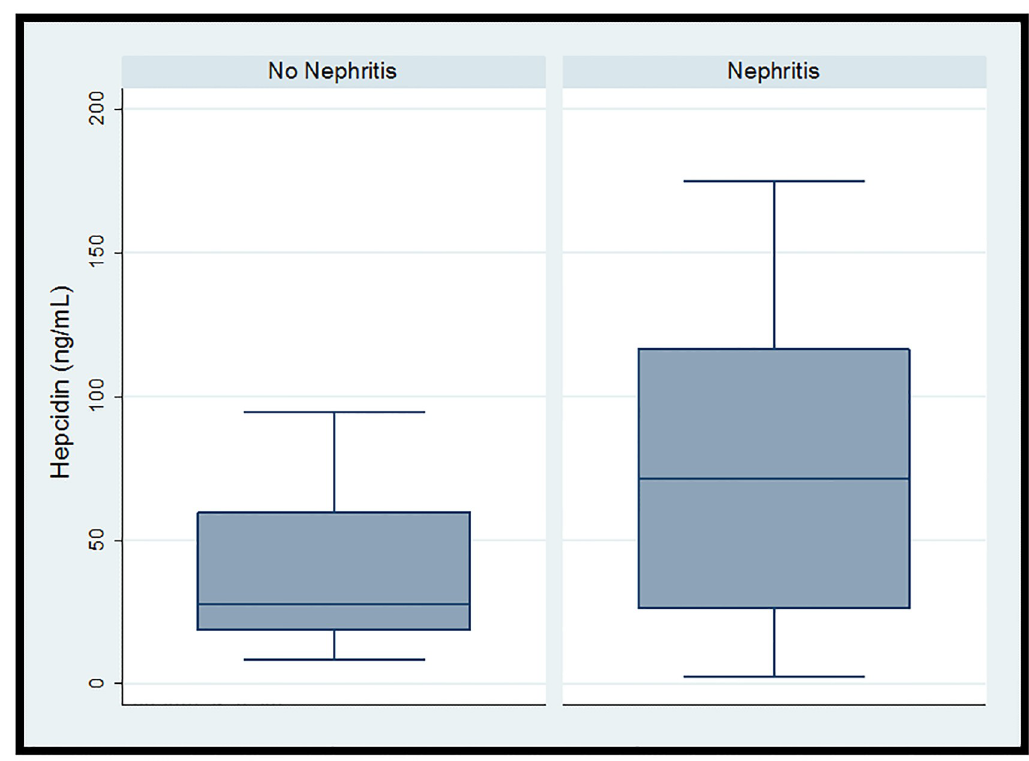
Fig 3. Boxplots of serum hepcidin and pulse wave velocity in children with systemic lupus erythematosus by nephritis status.